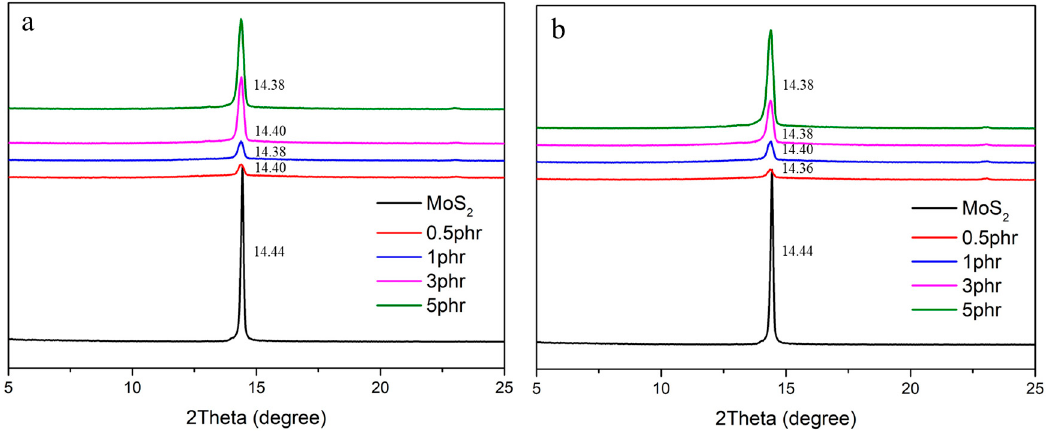
Figure 5. X-ray diffraction (XRD) patterns of MoS 2 -butyl rubber nanocomposites: ( a ) MoS 2 -ethanethiol-butyl rubber and ( b ) MoS 2 -nonanethiol-butyl rubber.